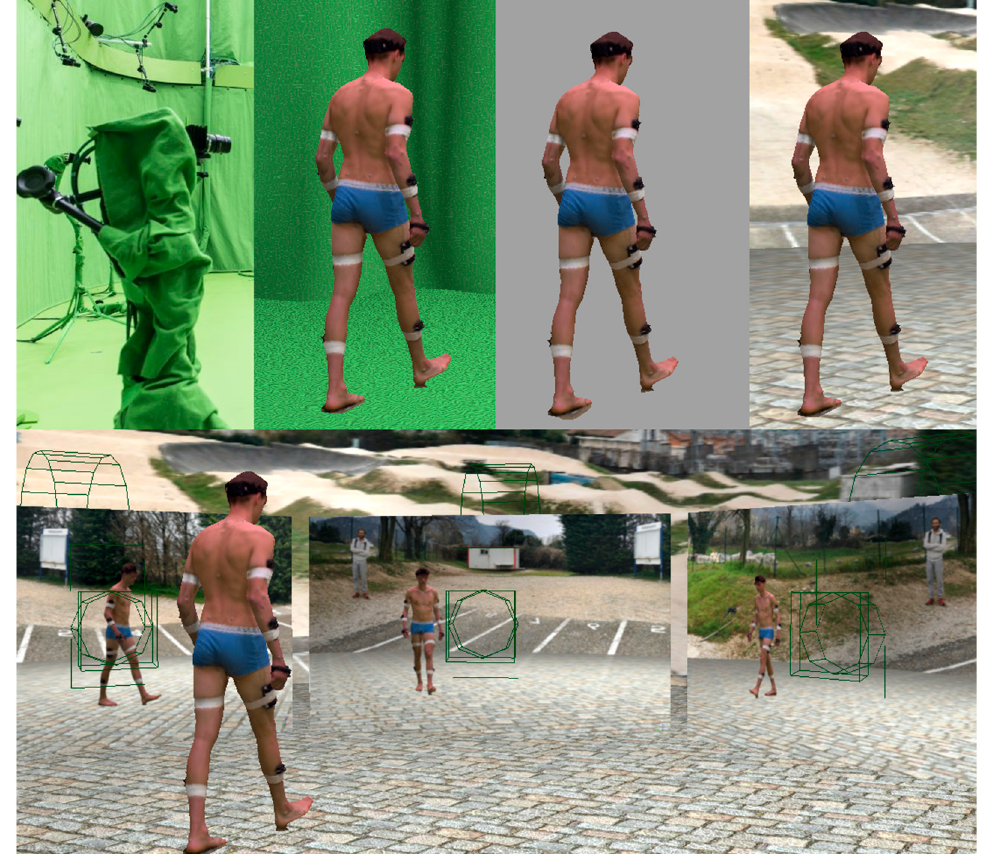
Figure 2. Participant’s 3D textured meshes were extracted using 68 video cameras in the studio, and then placed in a virtual environment. The scene was then filmed from 8 virtual cameras.